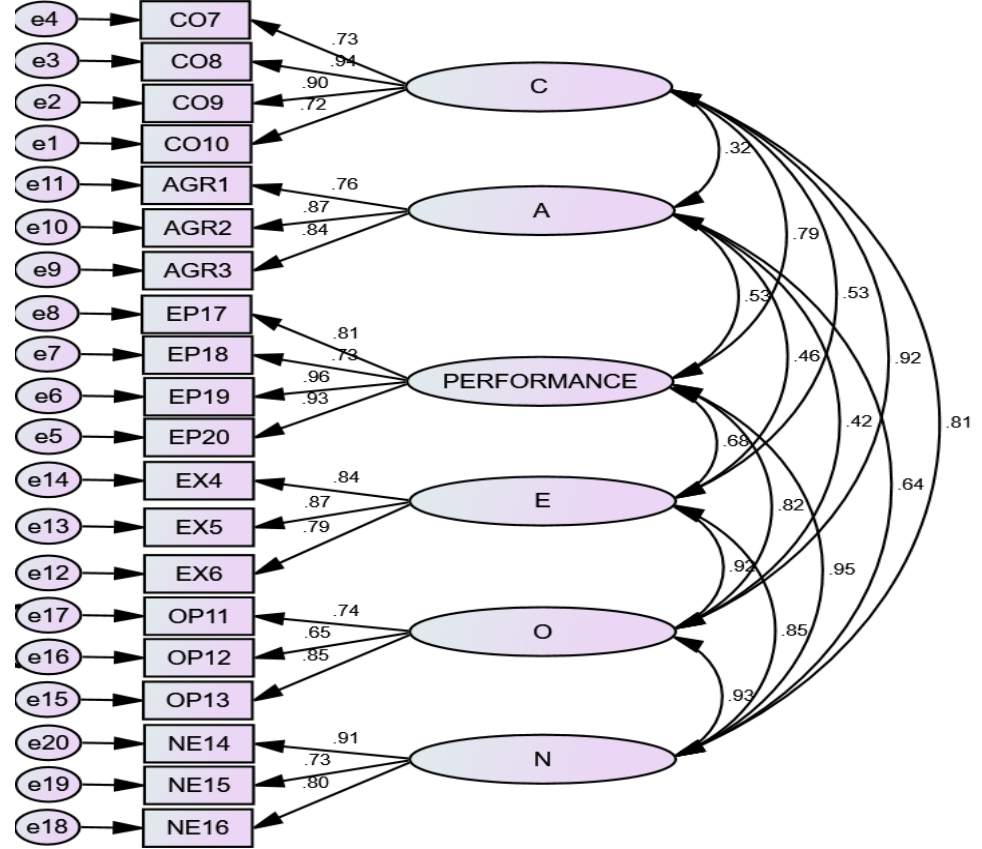
Figure 1. The results of first order CFA. Model fit: ( χ 2 (153, N = 281) = 399.23 p < 0.001, normed χ 2 = 3.609, RMSEA = 0.085, SRMR = 0.0520, CFI = 0.988, TLI = 0.988, NFI = 0.993, RFI = 0.971, IFI = 0.912, PCFI = 0.750 and PNFI = 0.780).